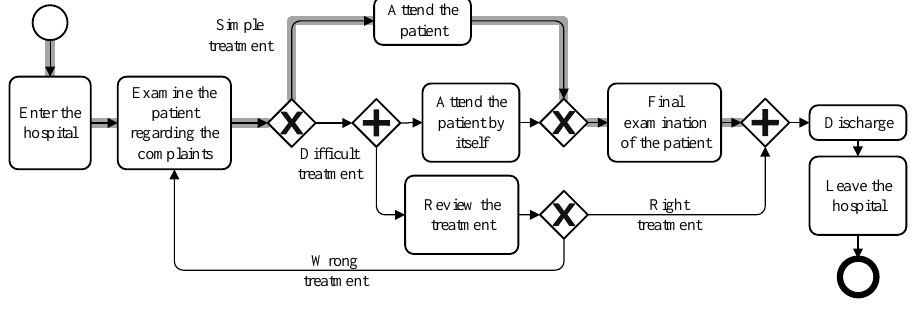
Figure 2. A deadlock (grey path) in the example